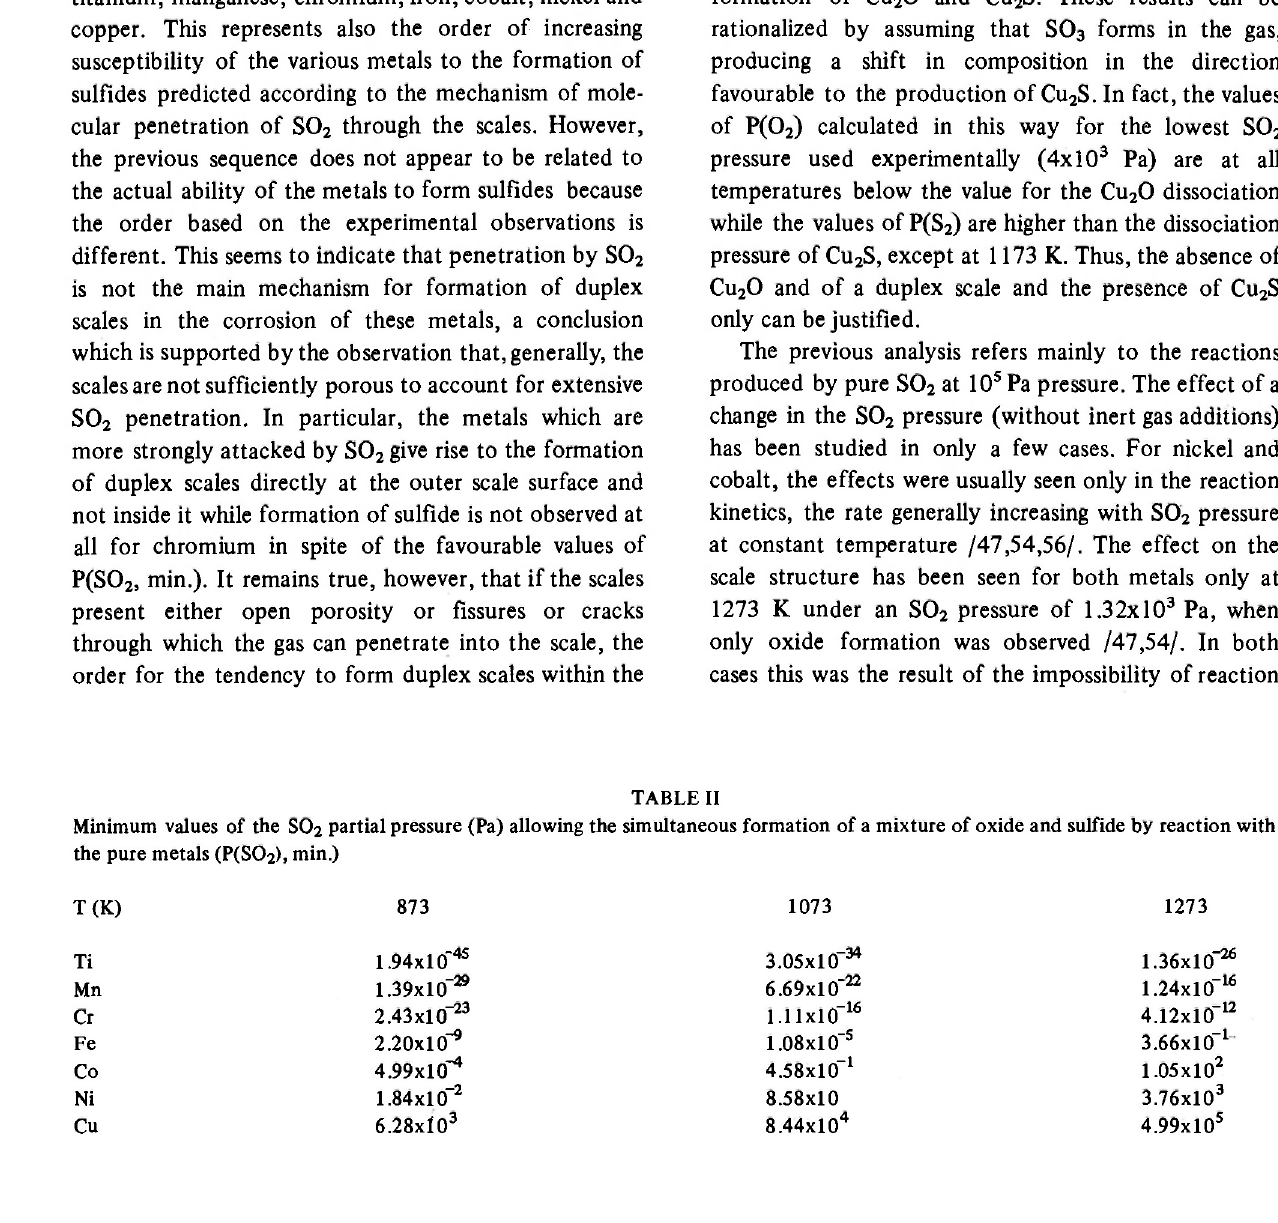
Minimum values of the S0 2 partial pressure (Pa) allowing the simultaneous formation of a mixture of oxide and sulfide by reaction with the pure metals (P(S02),